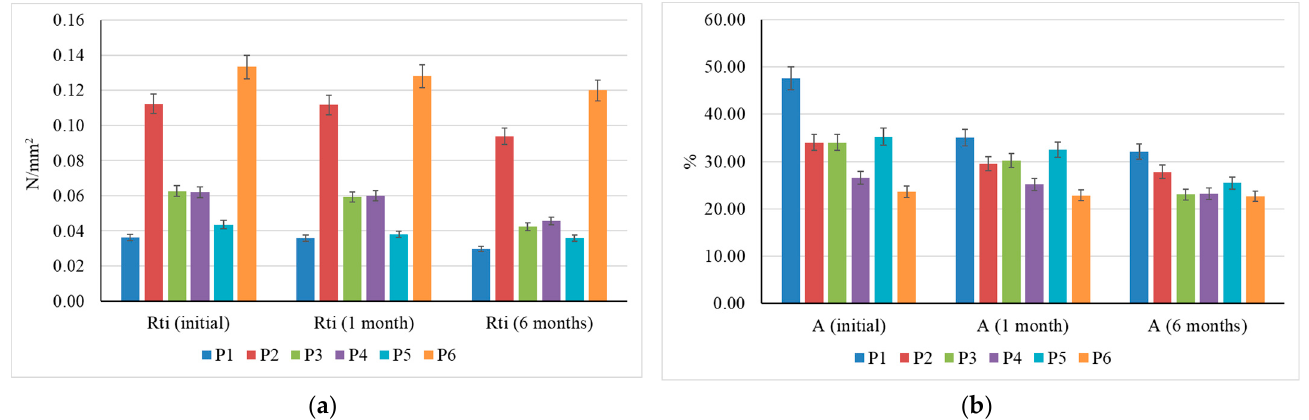
Figure 8. Variation in tensile strength ( a ) and elongation at break ( b ) after soil retention.